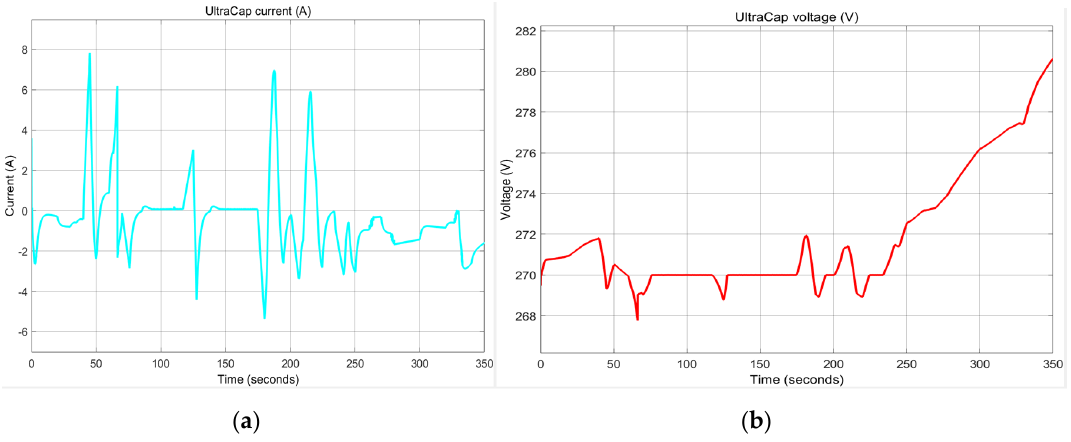
Figure A9. Li-ion battery specific variables. ( a ) Battery current; ( b ) battery voltage; ( c ) battery SOC.